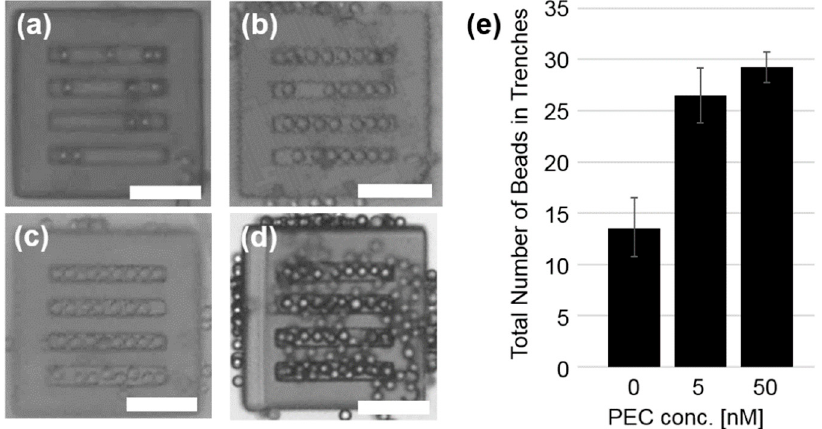
Figure 3. Microscope images of square templates with straight trenches agitated with polystyrene beads. Concentrations of 4MDa PEG in solutions are ( a ) 0 nM, ( b ) 5 nM, ( c ) 50 nM, and ( d ) 500 nM, respectively. Scale bars = 100 µ m. ( e ) Average number of the beads confined in trenches among four template components. Data at c PEG = 500 nM were omitted because of aggregation.